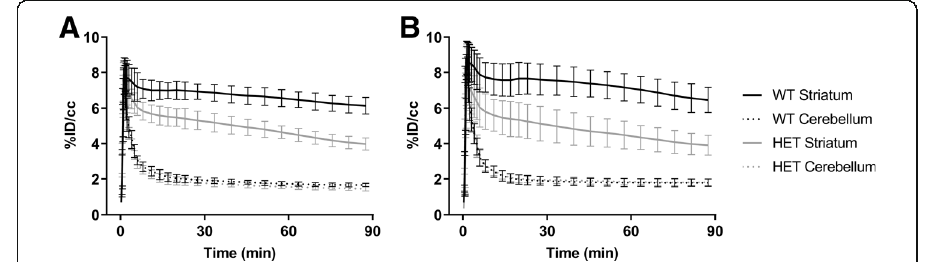
Fig. 2 Time activity curves of [ 18 F] fallypride in striatum and cerebellum (reference region) at the age of 9